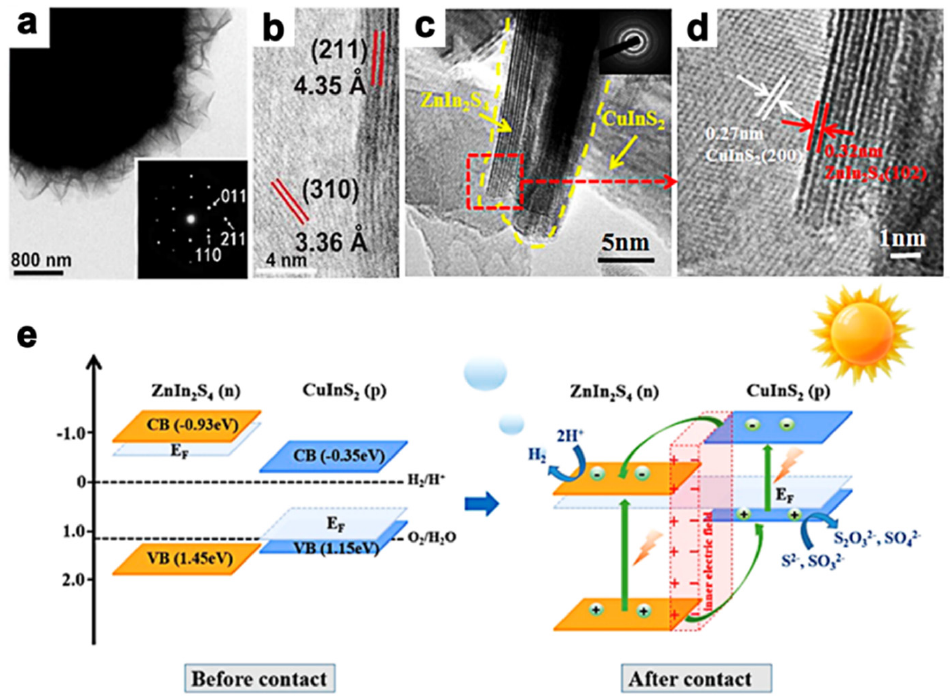
Figure 1. TEM ( a ) and HRTEM ( b ) of AgIn 5 S 8 /ZnIn 2 S 4 heteromicrospheres. Reprinted with permission from Ref. [57]. Copyright 2015, Royal Society of Chemistry. ( c , d ) HRTEM of ZnIn 2 S 4 @CuInS 2 composites [53]. ( e ) Schematic diagrams of the formation of p–n junction and proposed charge separation process in the ZnIn 2 S 4 @CuInS 2 core–shell photocatalysts. Reprinted with permission from Ref. [53]. Copyright 2020, American Chemical Society.